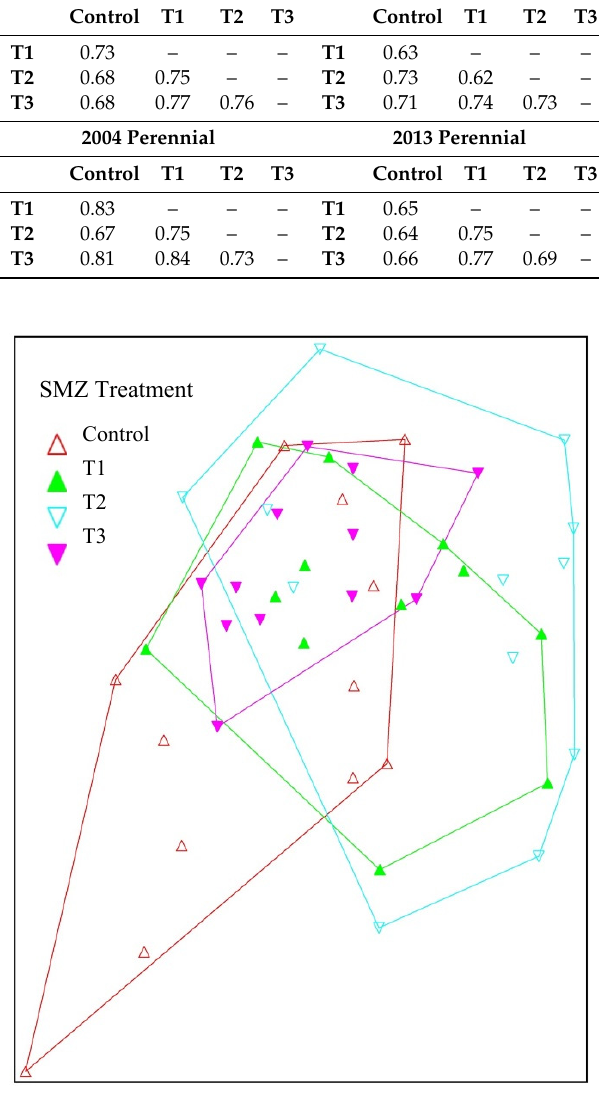
Figure 4. A nonmetric multidimensional scaling (NMDS) plot of benthic macroinvertebrate communities collected from Robinson Forest SMZ streams which summarizes the variation between SMZ treatments. T1, T2, and T3 strongly overlap, while the Controls exhibit some outliers, reflecting lower overall abundances and weaker similarity in these streams relative to the SMZ treatments.